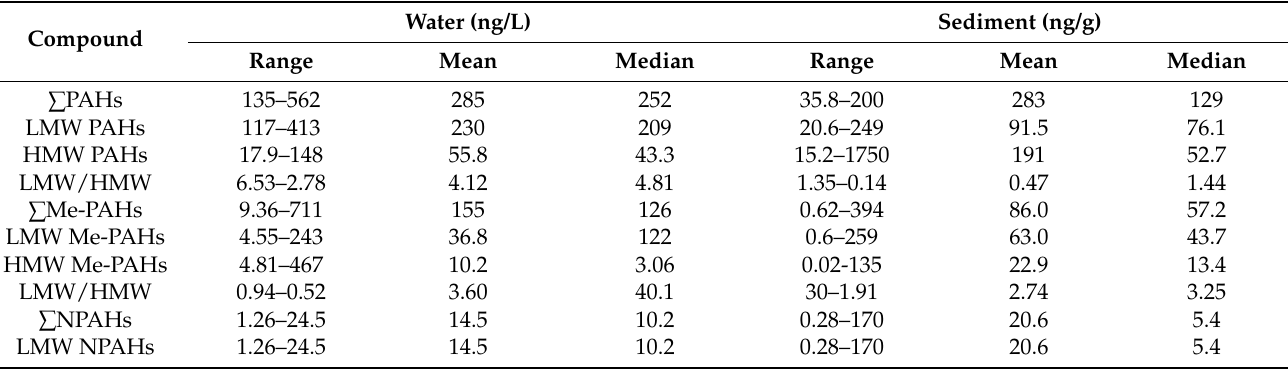
Table 1. Concentrations (ng/L), (ng/g) of ∑ 16 PAHs, ∑ 33 Me-PAHs, and ∑ 12 NPAHs in water and sediment samples from the Songhua River, Northeast